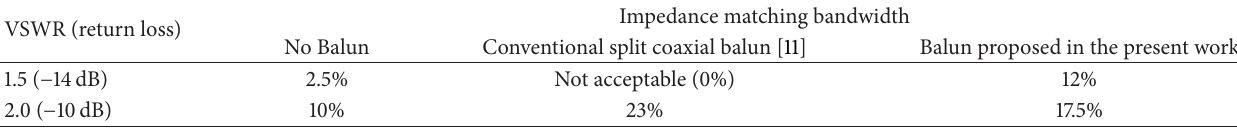
Impedance matching bandwidth